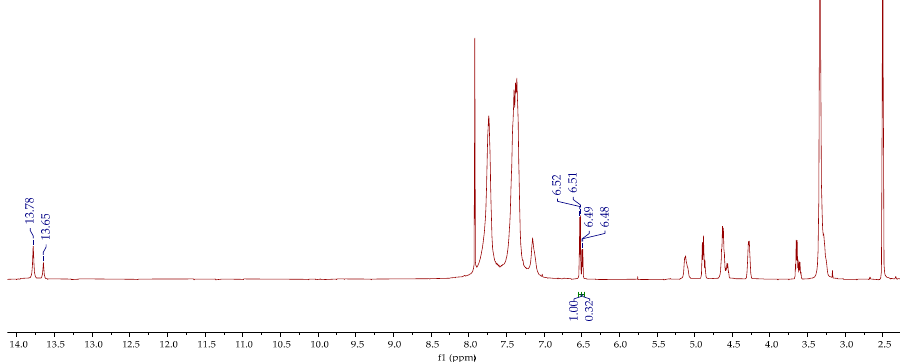
Molecules 2021 , 26 , x FOR PEER REVIEW Scheme 5. Protonation and methylation of complex 4 to obtain the corresponding NHCs.